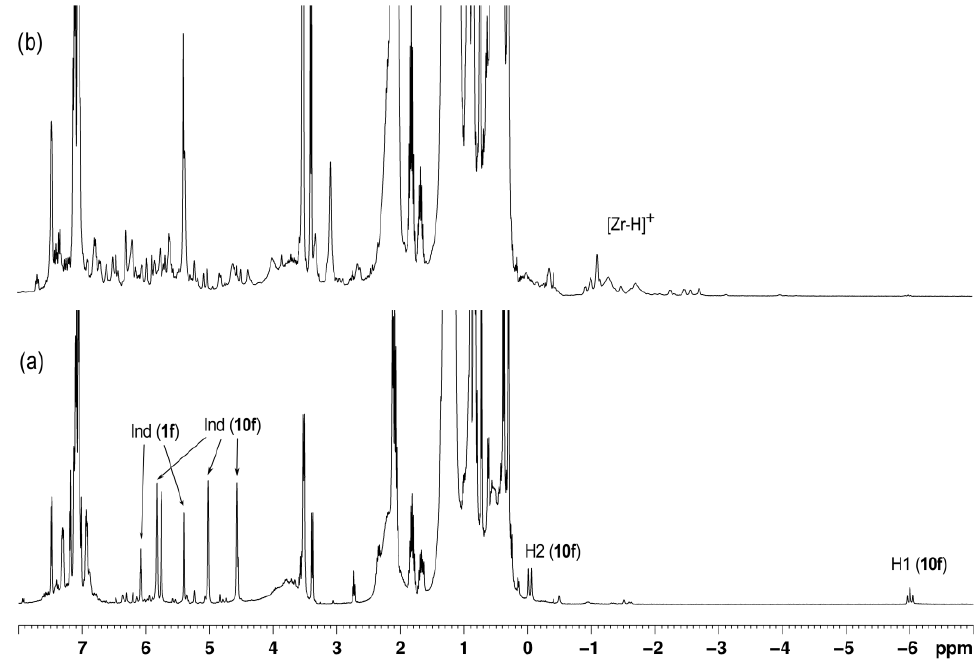
Figure 2. 1 H NMR spectrum of the Ind 2 ZrCl 2 ( 1f )−HAlBu i2 −[Ph 3 C][B(C 6 F 5 ) 4 ] system in C 7 D 8 (298 K): ( a ) [Zr]:[Al]:[B] = 1:3:0.2; ( b ) [Zr]:[Al]:[B] =